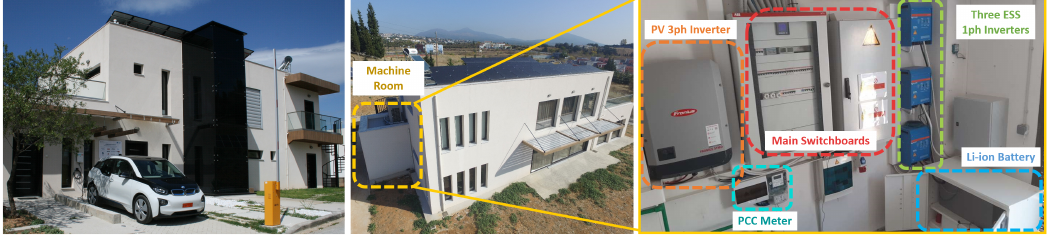
Figure 3. CERTH MG in